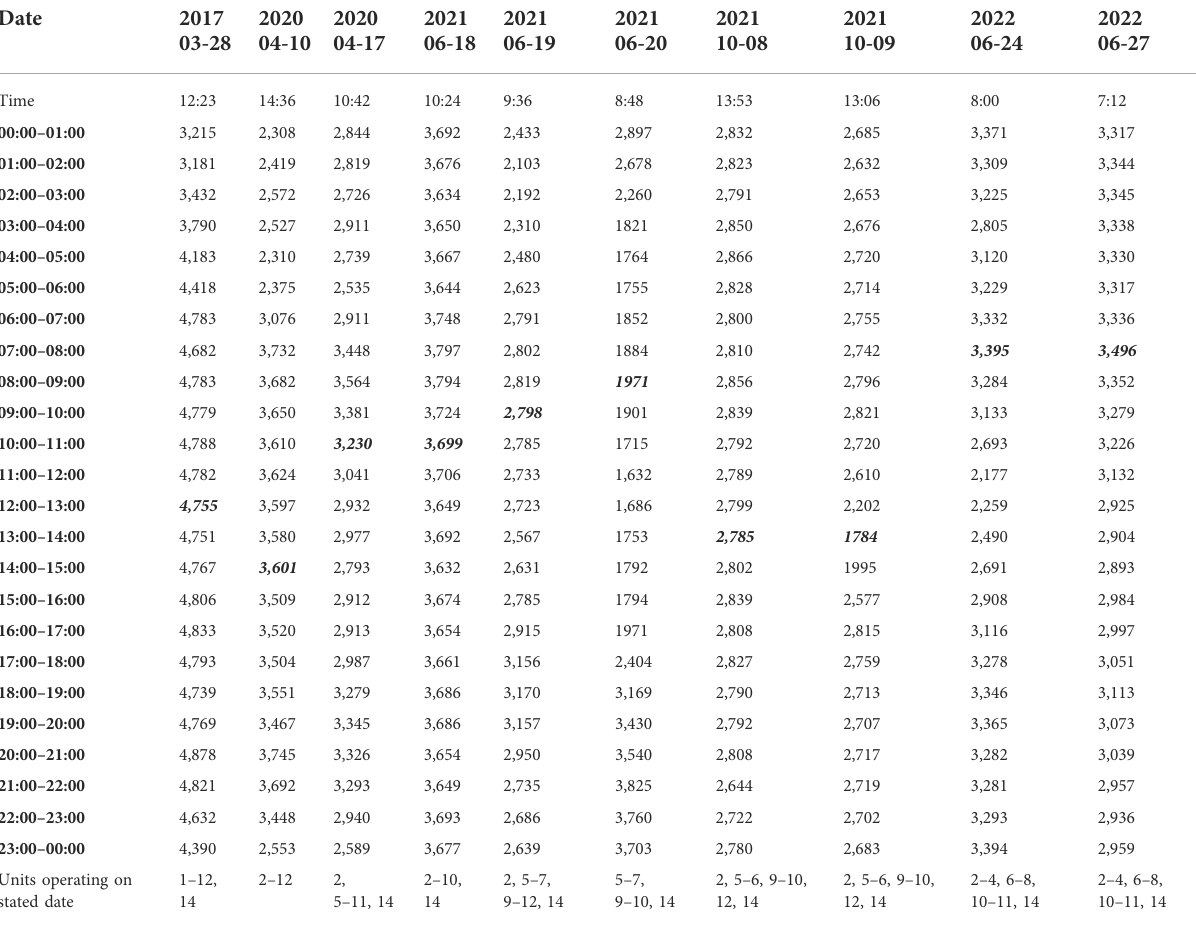
TABLE 4 Reported hourly power generation for the Be ł chat ό w Power Station in kilowatts (kW) from the European Network or Transmission System Operators for Electricity (ENTSO-E) Transparency Platform. Values shown are taken as the sum of the reported hourly generation (kW) for the units speci fi ed in the fi nal row. The overpass time is given in the second row with the corresponding hourly power generation for that time indicated by bold